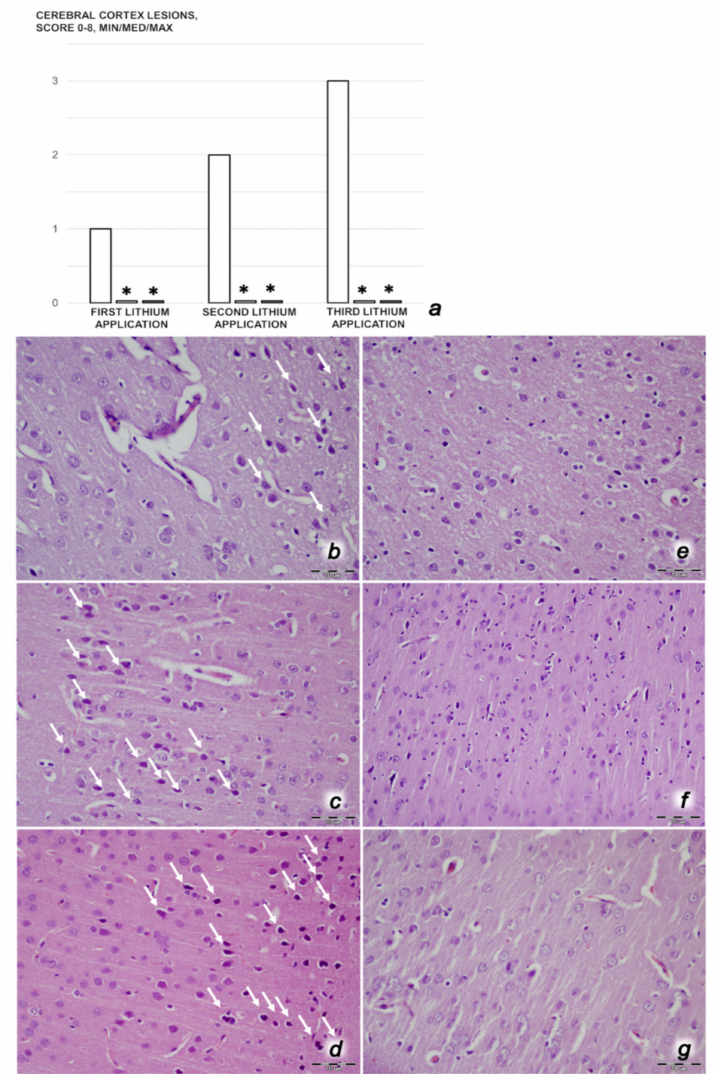
Figure 14. Brain pathology. Neuropathological changes of the cerebral cortex. ( a ) Semiquantitative neuropathological scoring system of cerebral cortex lesions in the lithium rats after the first, second, and third lithium administration (500 mg/kg/day intraperitoneally for 3 consecutive days). BPC 157 10 µ g/kg (light gray bars), 10 ng/kg (dark gray bars); saline 5 mL/kg (white bars) given intraperi- toneally after each of the three lithium administrations. Six rats/group/interval. Min/Med/Max, * p < 0.05, at least vs. control. In control rats a continuous increase rate of affected area occurred, from grade 1 (less than 20 percent of cerebral cortex area affected with a few karyopyknotic neuronal cells) to grade 3 (up to 75 percent of cerebral cortex area affected with more extensive karyopyknotic areas) following the order of lithium administration, whereas in BPC 157 rats no neuronal changes were found. Illustrative presentation of analyzed area of cerebral cortex lesions in control ( b – d ), and BPC 157-treated rats ( e , f ); first lithium application ( b , e ), second lithium application ( c , f ), and third lithium application ( d , g ). A marked edema and congestion persisted in the control lithium-treated rats after each of the lithium administrations with progression from mild to marked karyopyknosis of cortical neurons (arrows). In contrast, BPC 157-treated rats showed only mild edema persisting with no neuronal changes (HE; magnification × 400, scale bar 10 µ